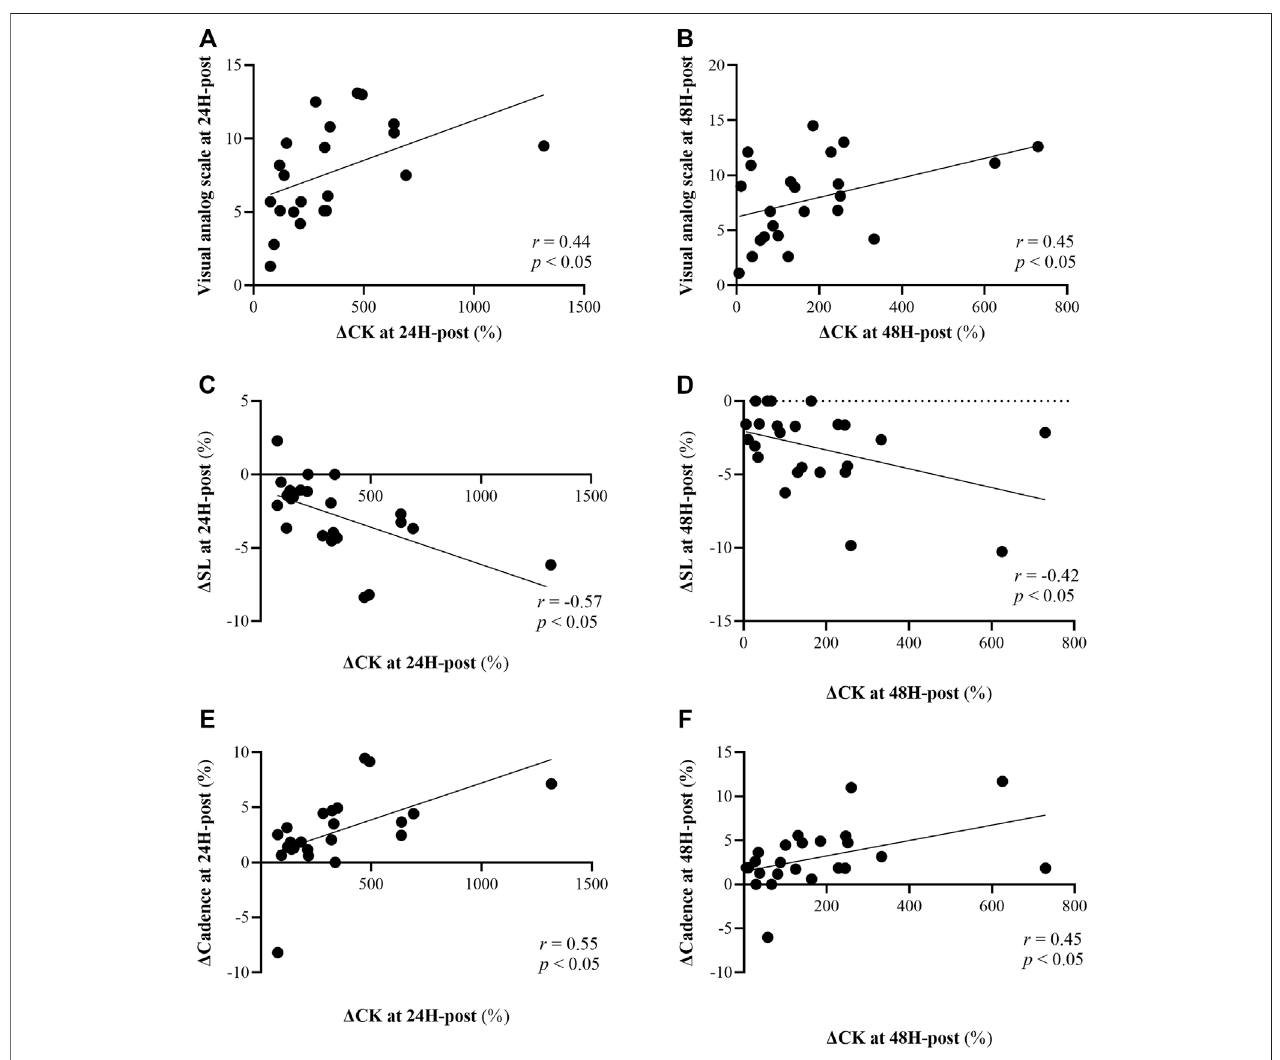
FIGURE 6 | Correlations between changes in creatine kinase (CK) at 24H-post (left panels) and 48H-post (right panels) 60 min downhill running (DHR) protocol relative to baseline and: Visual analog scale (15 point scale) at 24H-post [panel (A) ] and 48H-post [panel (B) ] DHR, changes in stride length (SL) at 24H-post [panel (C) ] and 48H-post [panel (D) ] DHR compared to baseline, and changes cadence at 24H-post [panel (E) ] and 48H-post [panel (F) ] DHR compared to baseline.